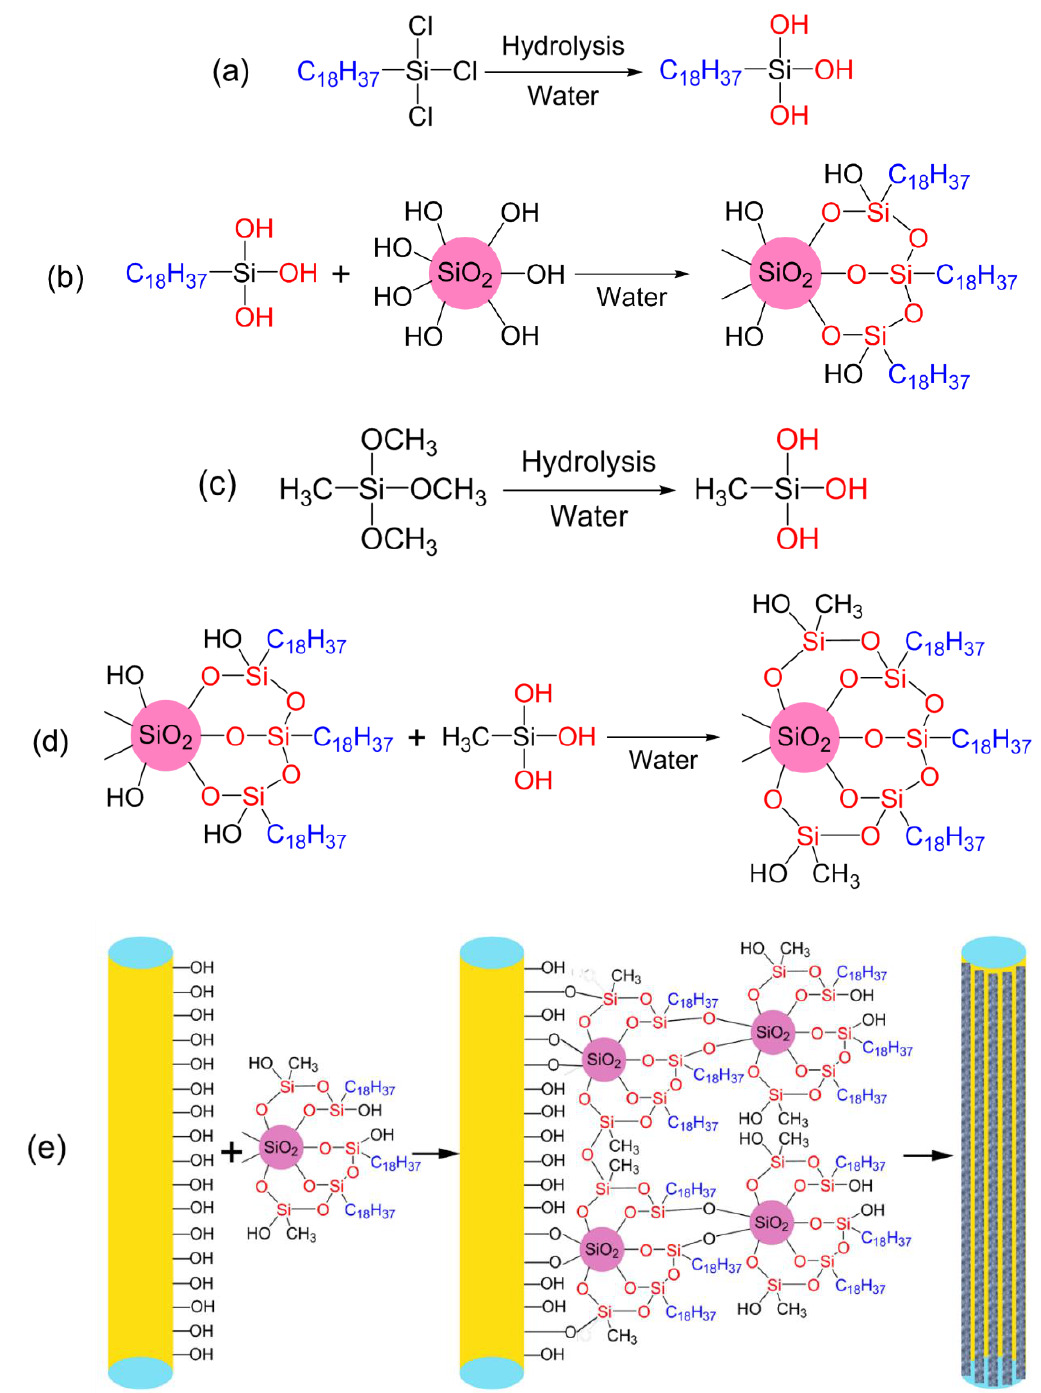
Figure 1. Fabrication processes of a superhydrophobic absorbent from CF. Hydrolysis of OTS ( a ); fabrication of hydrophobic SiO 2 particles ( b ); hydrolysis of MTMS ( c ); fabrication of hydrophobic SiO 2 @OTS@MTMS particles ( d ); and fabrication of superhydrophobic CF ( e ).